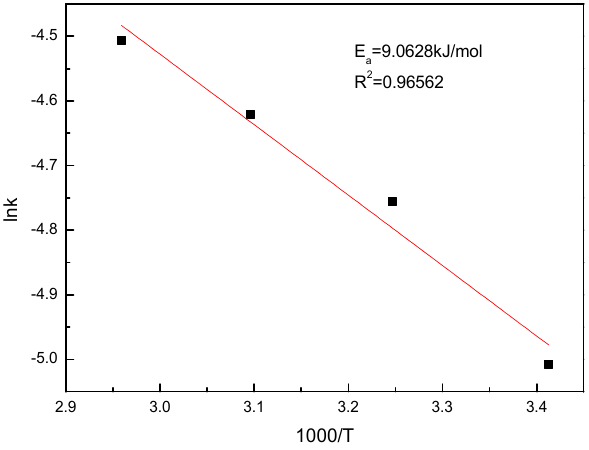
Figure 6. Arsenic removal kinetic at different reaction temperatures.